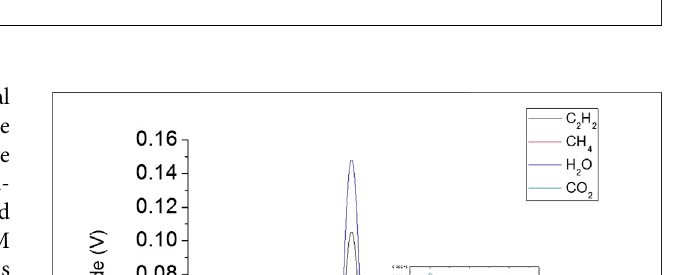
FIGURE 3 | Experimental setup.